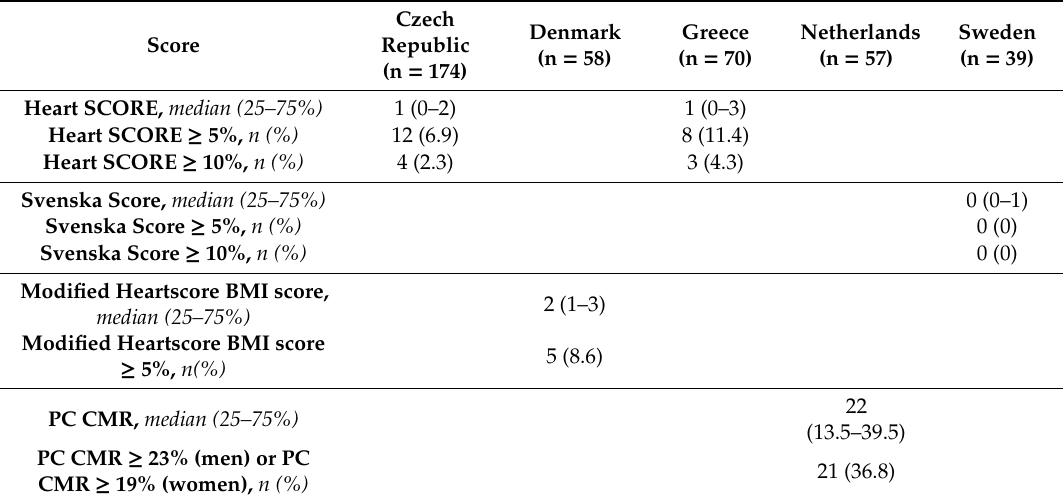
Table 3. Cardio-vascular risk scores among individuals accepting risk assessment by country and tool used (n =